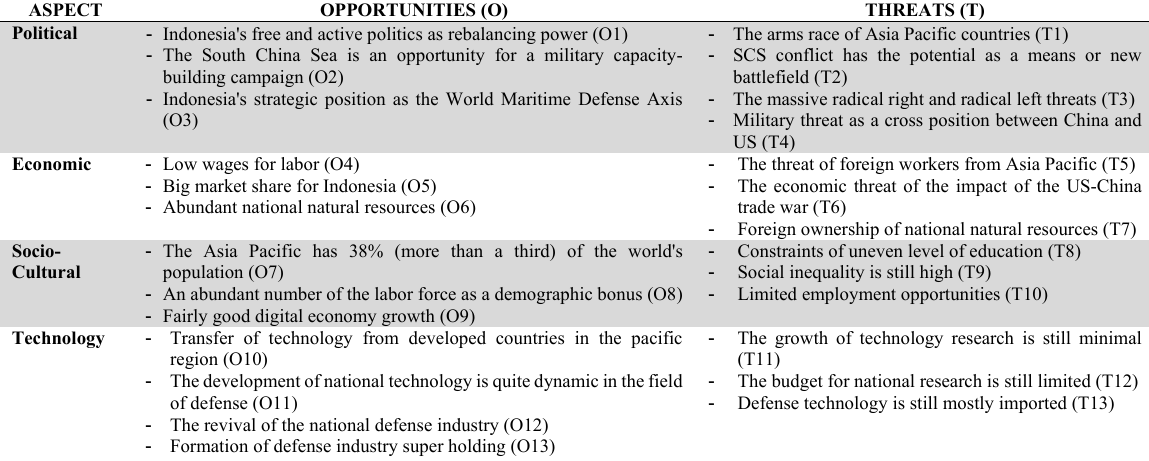
External Factor Analysis ASPECT